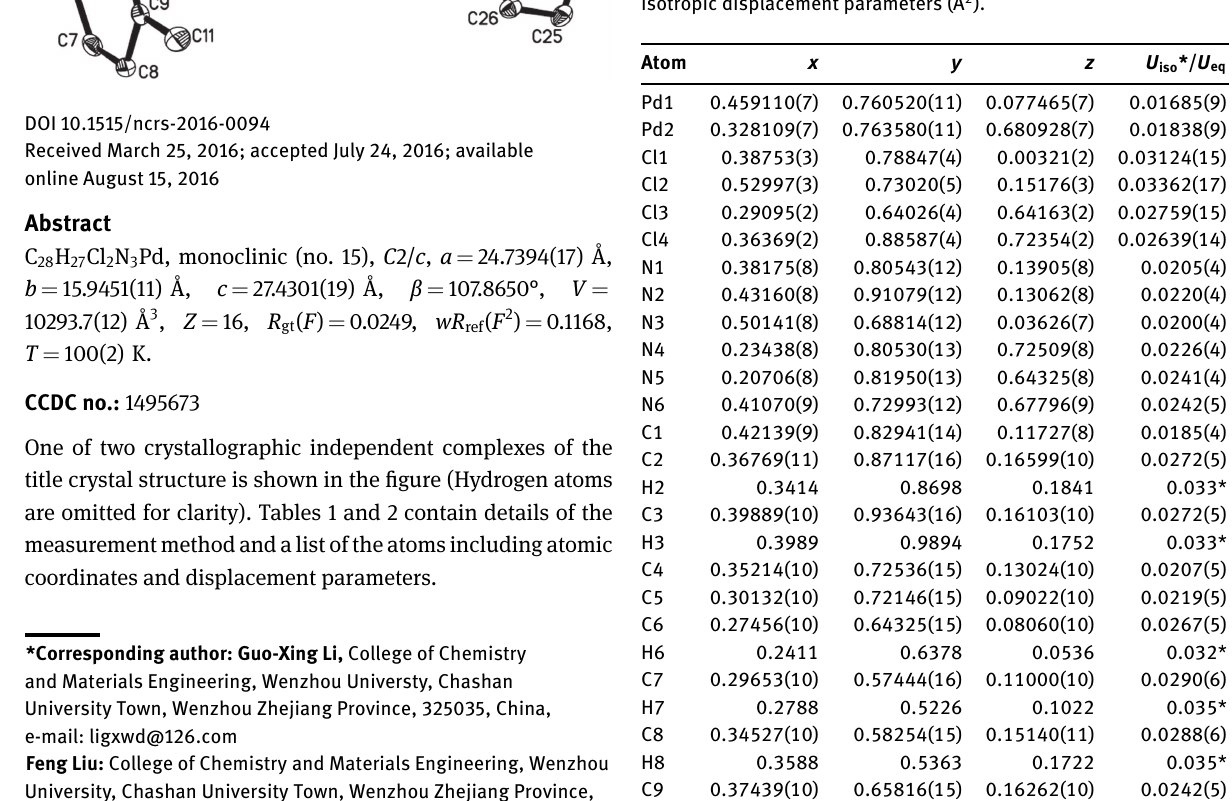
Table 2: Fractional atomic coordinates and isotropic or equivalent isotropic displacement parameters (Å 2